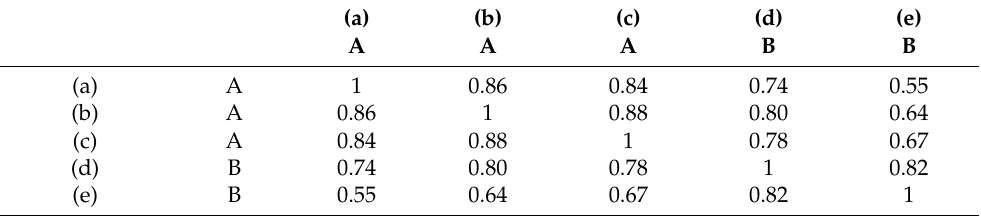
Figure 10. Mean values of RSSI as a function of distance including the limits of the confidence interval for a confidence of 0.8. Table 7. Spatial correlation of RSSI, A and B reference to two providers under